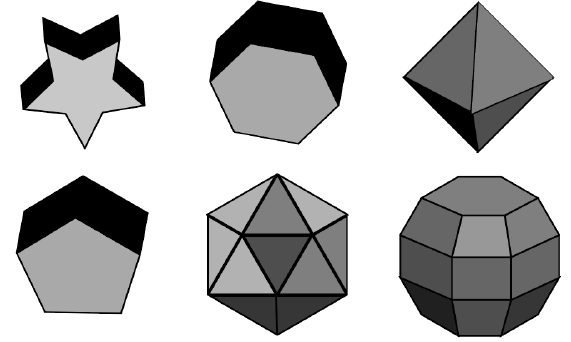
Figure 2. The particles with N-fold symmetric geometry.